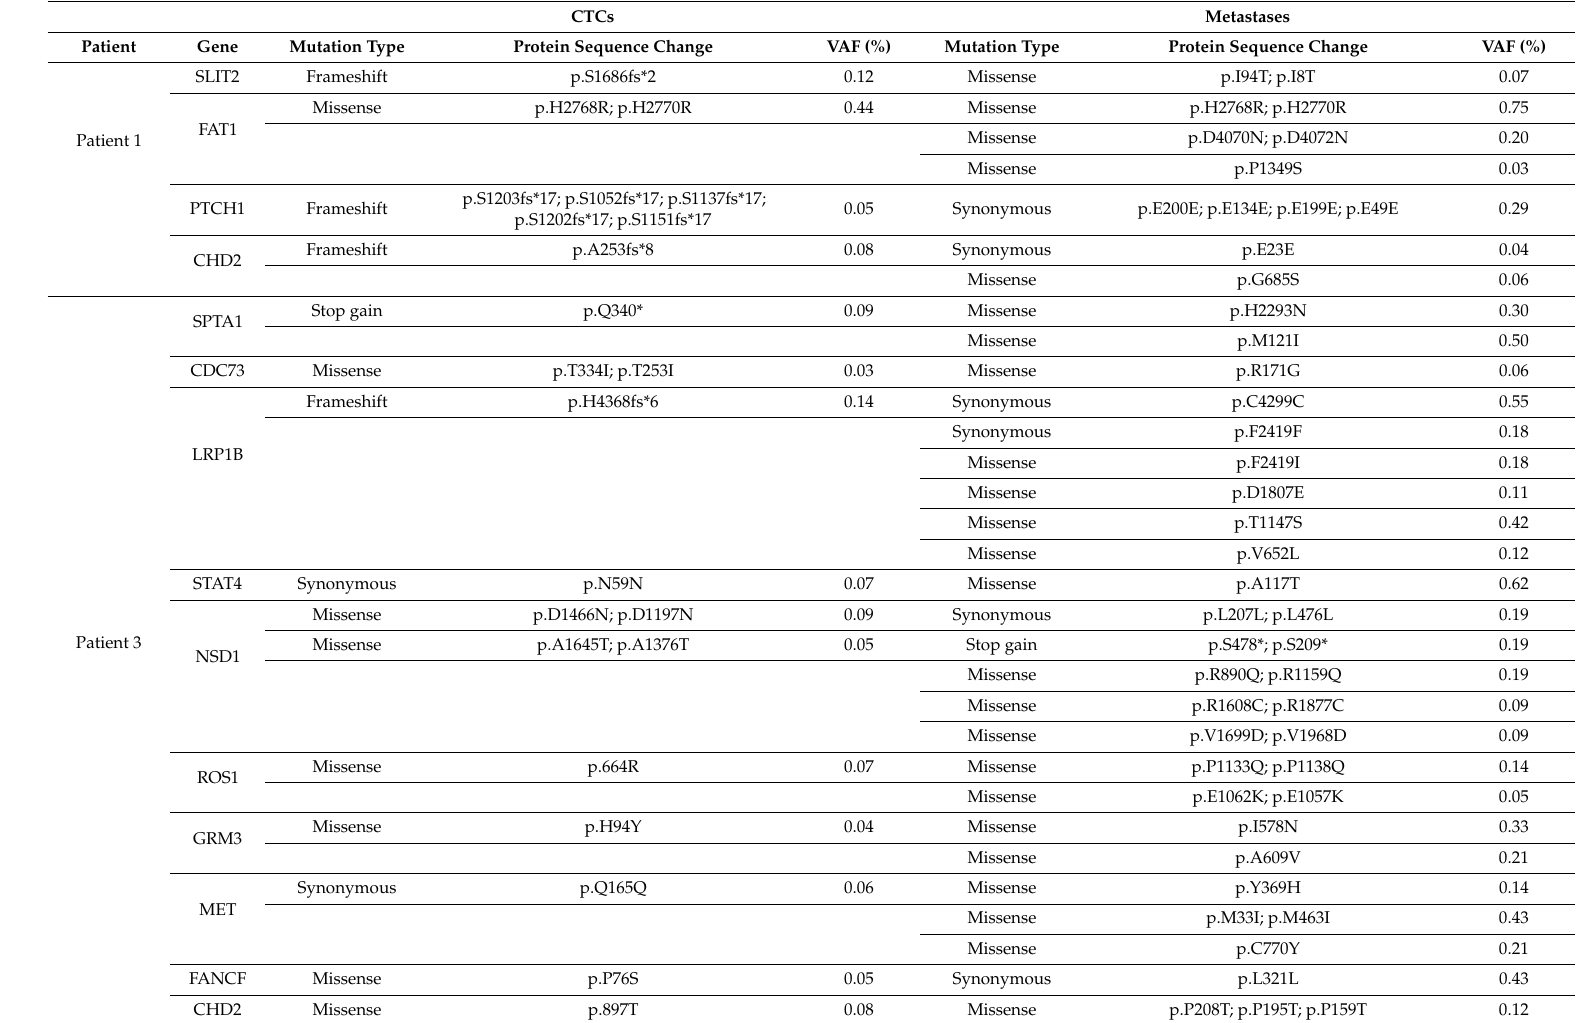
Table 3. Common actionable genes found in CTCs and FFPE metastatic